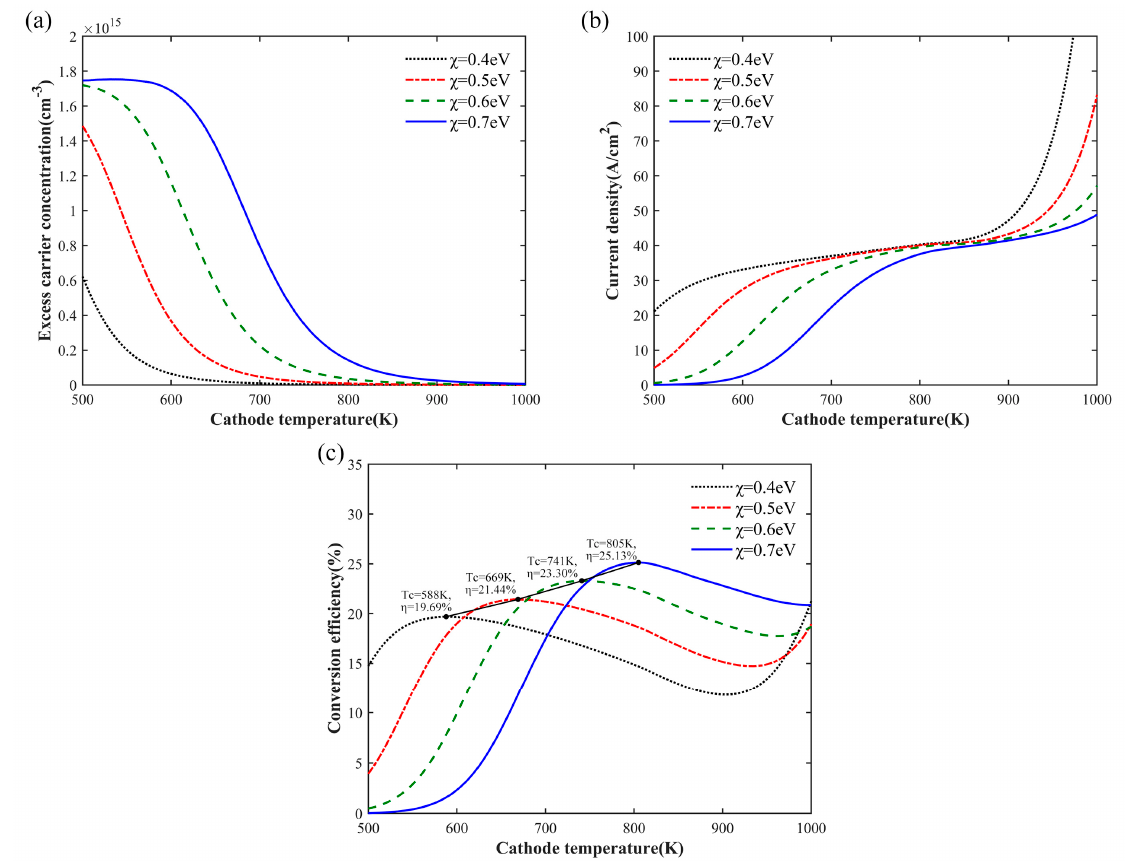
Figure 5. Under di ff erent electron a ffi nities and T a = 500 K, the cathode temperature dependence of ( a ) the excess electron concentration, ( b ) output current density, and ( c ) conversion e ffi ciency.